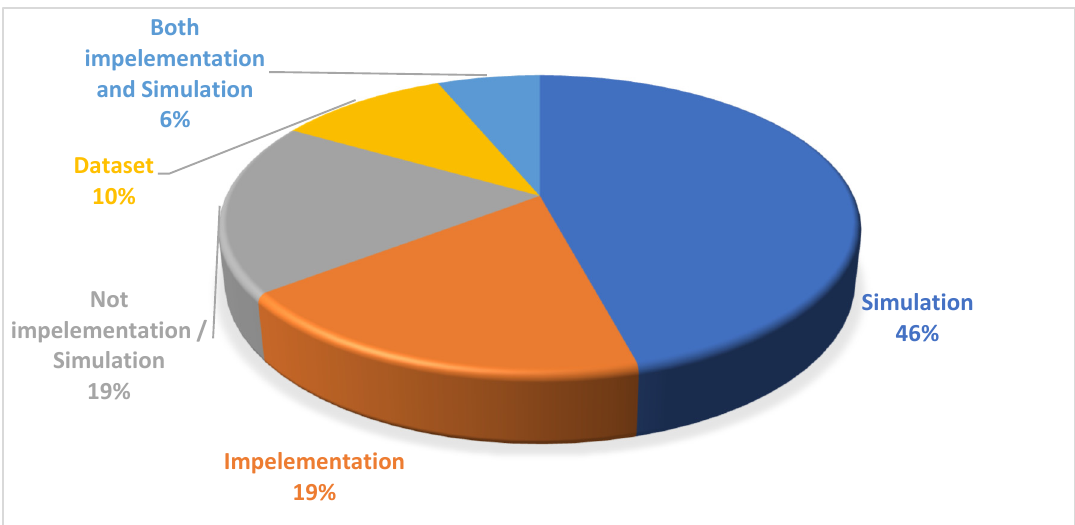
Figure 6. Evaluation environments are